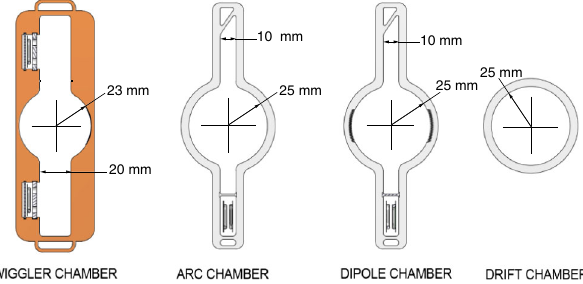
FIG. 16. Vacuum chamber designs for magnetic elements in the ILC damping ring. The upper part of the figures correspond to the outer radius of the ring, when installed.